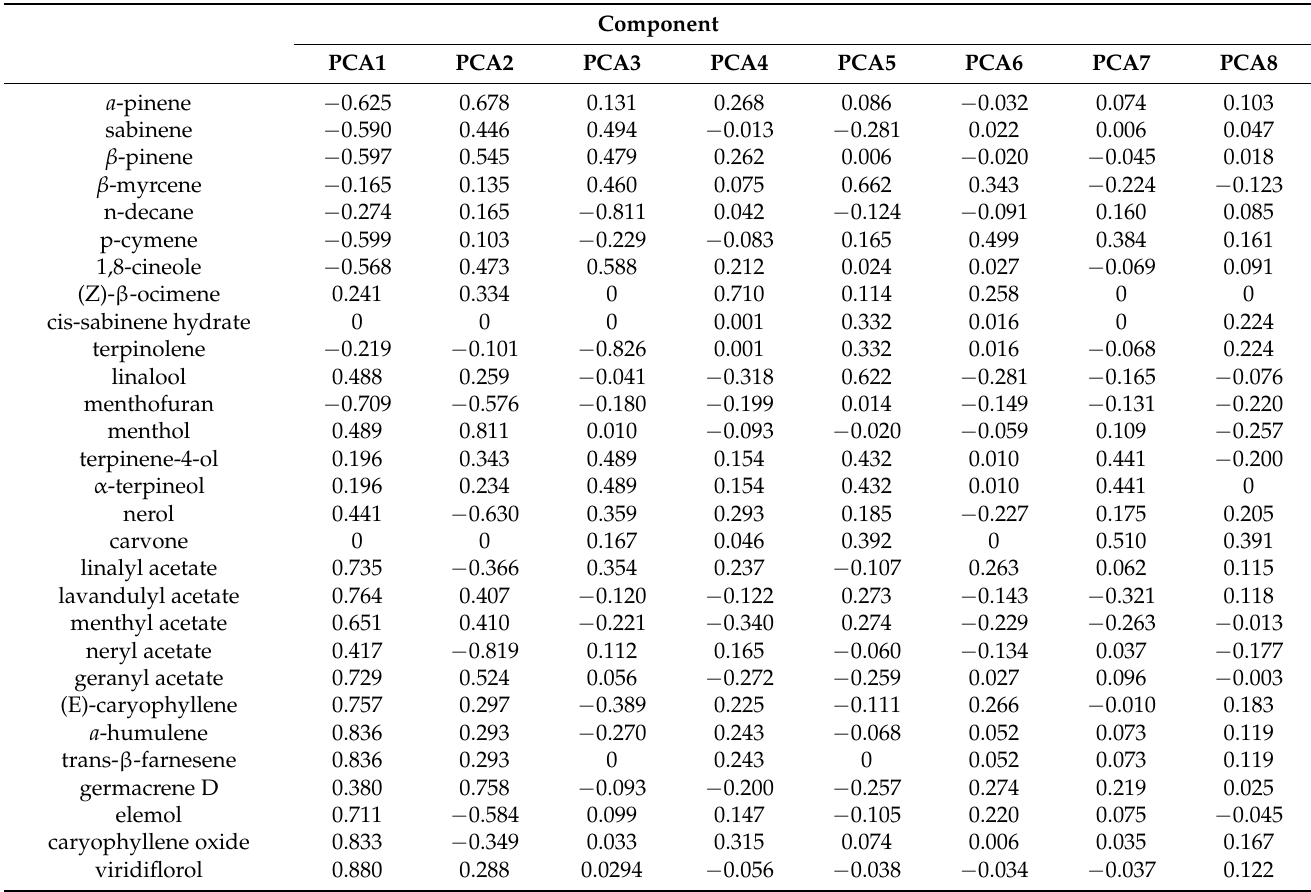
Table 6. PCA for essential oil constituents of M. aquatica populations from the Hyrcanian hotspot of